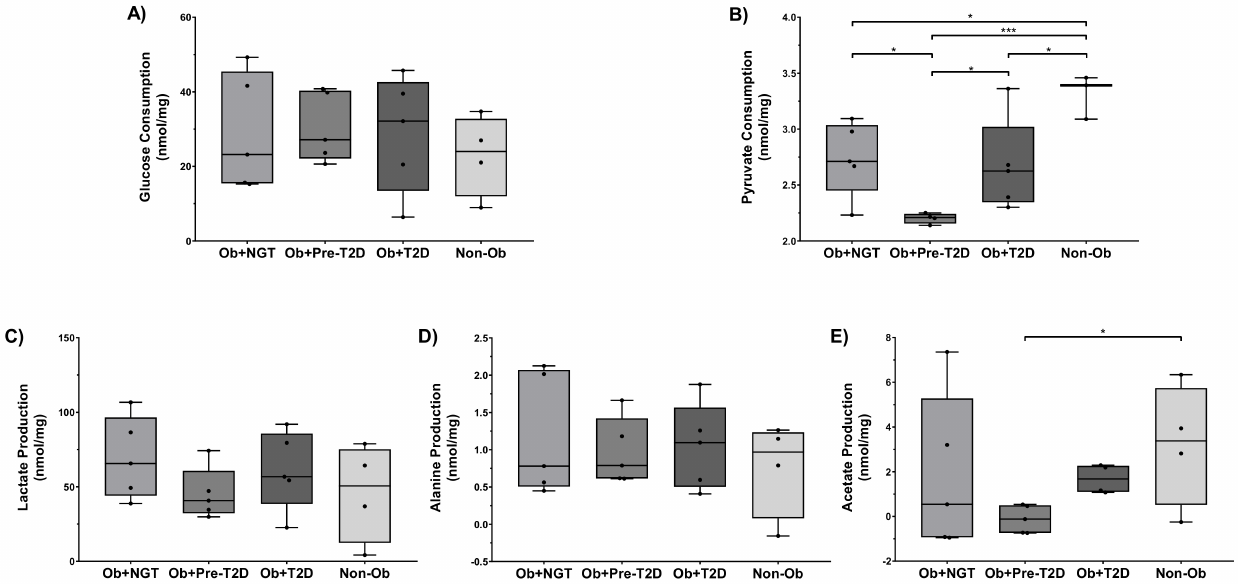
Figure 1. Glucose ( A ) and pyruvate ( B ) consumption and lactate ( C ), acetate ( D ) and alanine ( E ) production by visceral adipose tissue (VAT) explants. Subjects were grouped according to body mass index (BMI) and glycemic status (with obesity and euglycemia-Ob+NGT; with obesity and pre-diabetes-Ob+Pre-T2D; with obesity and T2D-Ob+T2D; without obesity-Non-Ob). Data are presented as boxplots with quartiles and all points plotted. * p < 0.05; *** p <